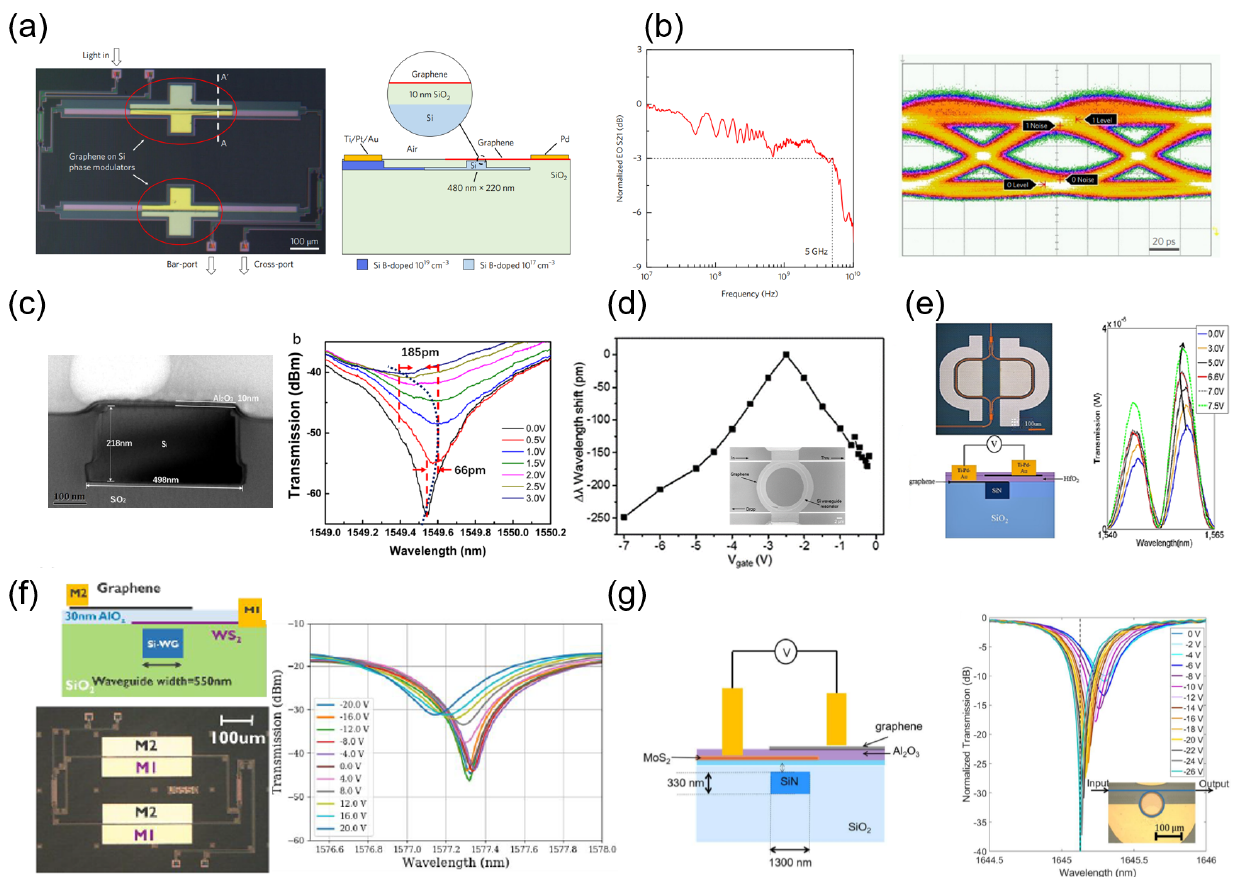
Figure 6. Graphene ER modulators. ( a , b ) Optical micrograph and cross-section of the MZI-based graphene phase modulator with an electro-optical S21 bandwidth 5 GHz and an NRZ eye diagram at 10 Gbps [45]. Reproduced from Ref. [45] with permission. ( c ) TEM image for interaction region in graphene ER modulator based on MZI structure and static optical transmission with a great blue shift of about 185 pm under different applied voltages, indicating an ER modulation driven by graphene [67]. Reproduced from [67] with permission. ( d ) Micro-ring-based ER modulation covered by SLG. Inset shows SEM image with graphene visible and covering the ring resonator [71]. Repro- duced from Ref. [71] with permission. ( e ) Optical micrograph and cross-section of the DLG-based (graphene-HfO 2 -graphene) ER modulator integrated on a Si 3 N 4 MZI structure. The optical transmis- sion with an arm-length difference of 100 µ m, indicating its ER modulation feature [68]. Reproduced from Ref. [68] with permission. ( f ) Left: schematic of the hybrid WS 2 -alumina-graphene